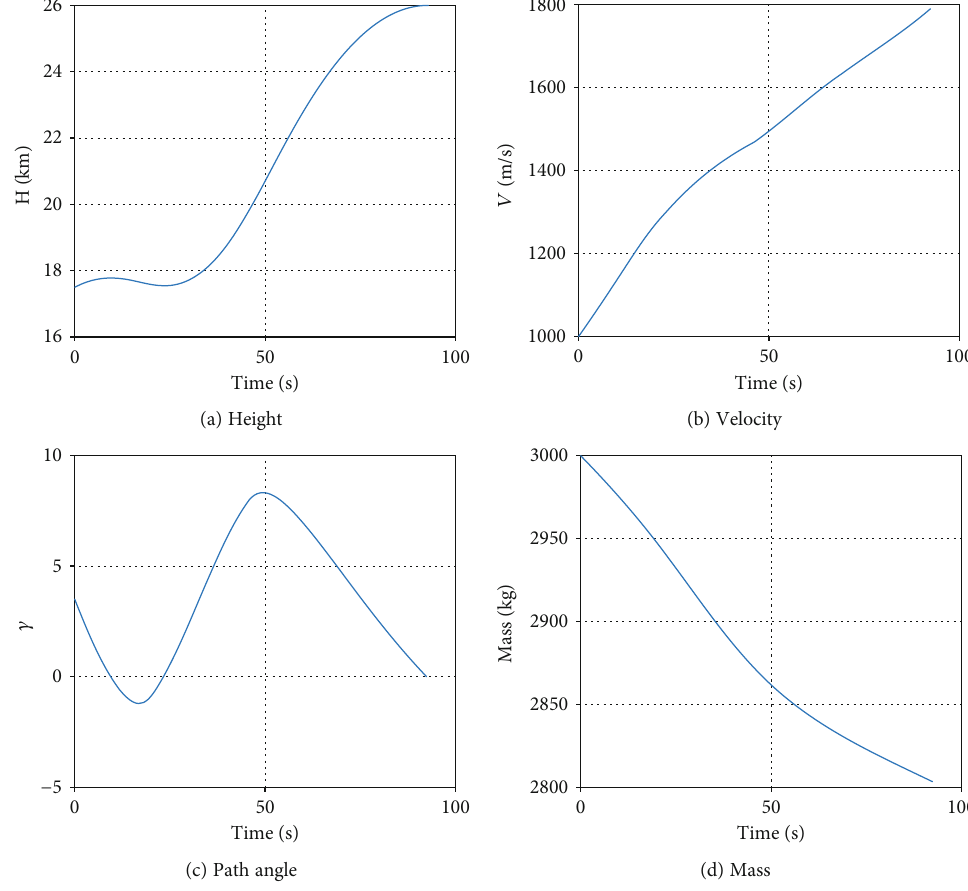
Figure 2: The optimization trajectory.